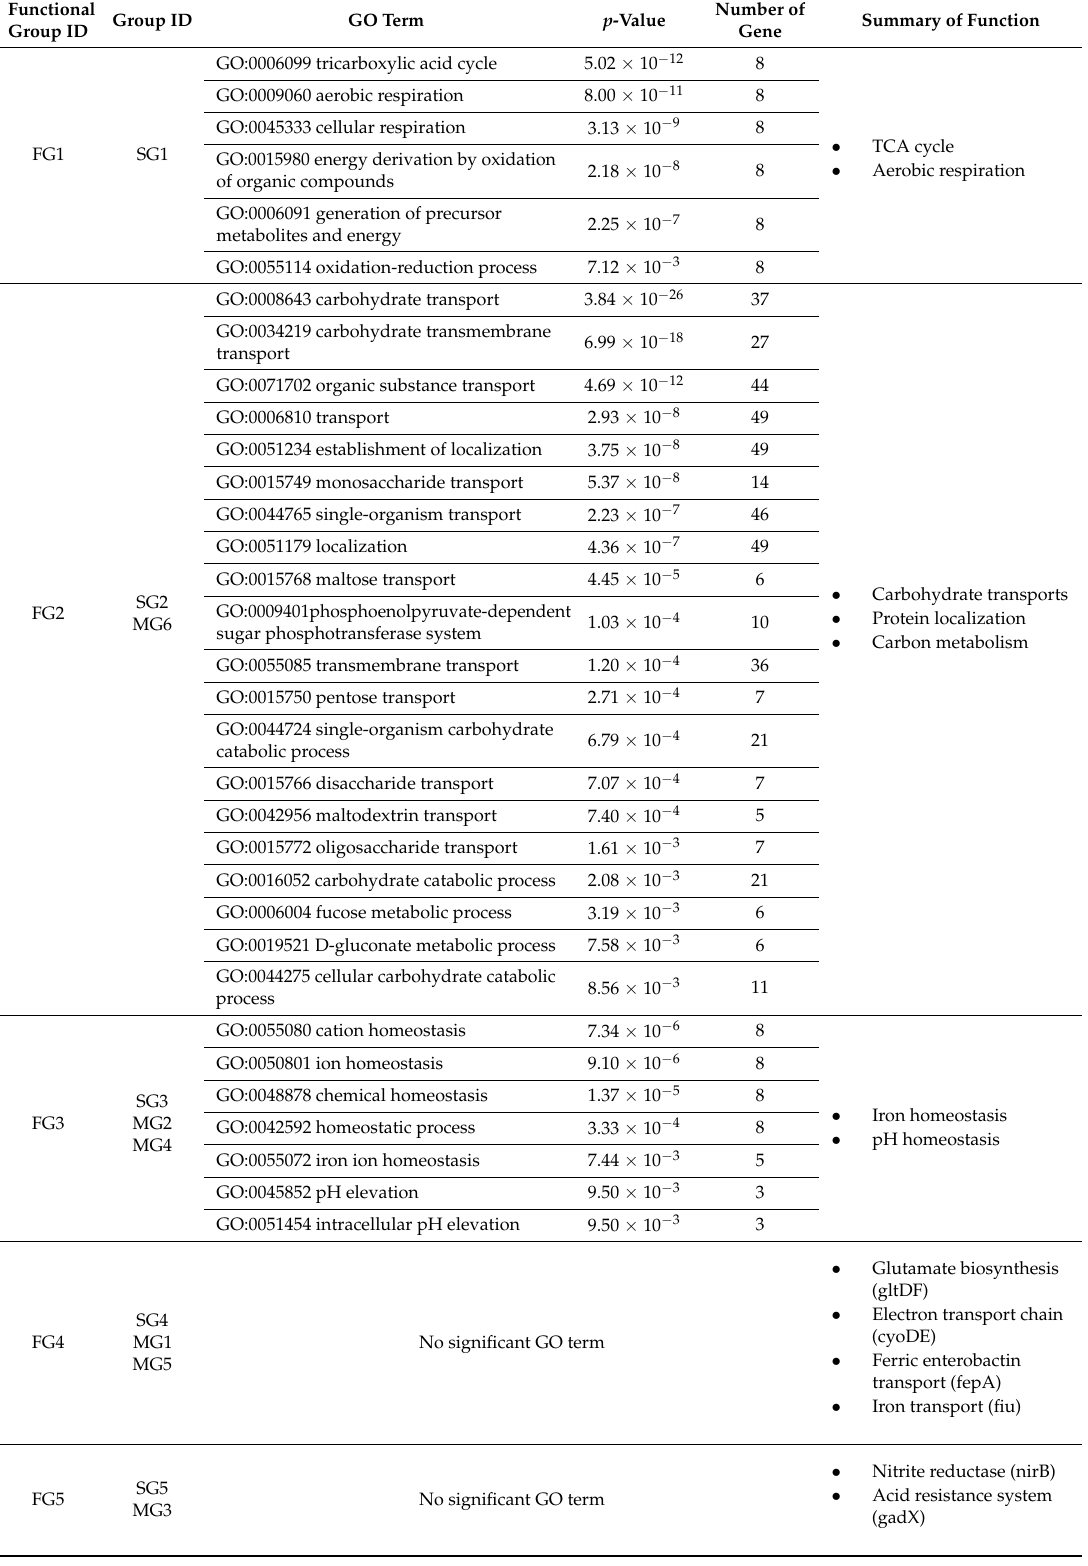
Table 2. Biological process ontology of CRP-FFLs. Associated GO terms and biological functions for each functional group are listed. Most functional groups with a small p -value are statistically